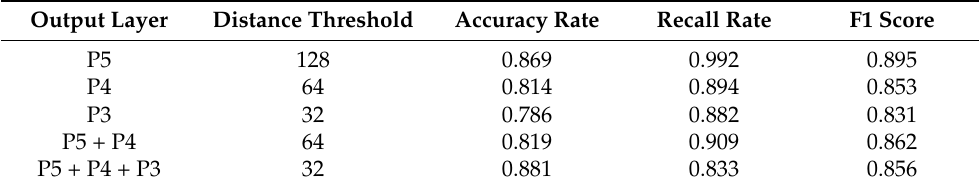
Table 1. The assessment result of each output layer when the threshold rate set as 0.5. Output Layer Distance Threshold Accuracy Rate Recall Rate F1